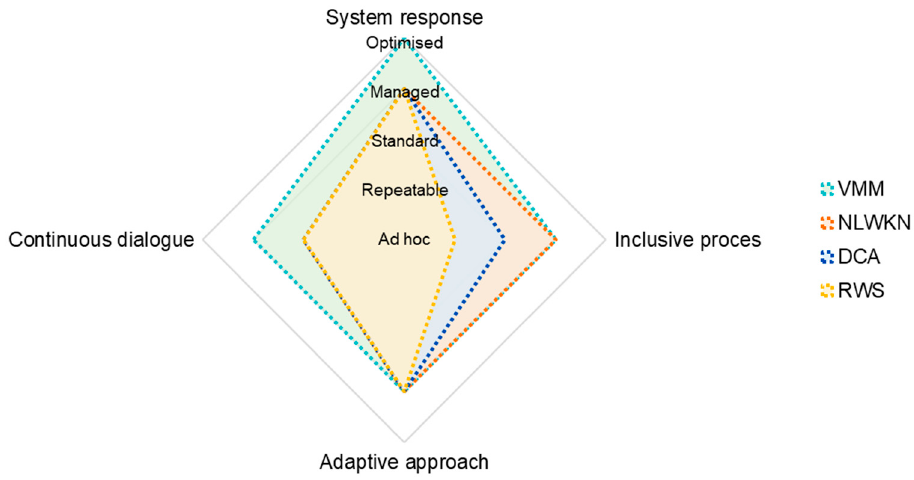
Figure 3. Design of the peer learning workshops.